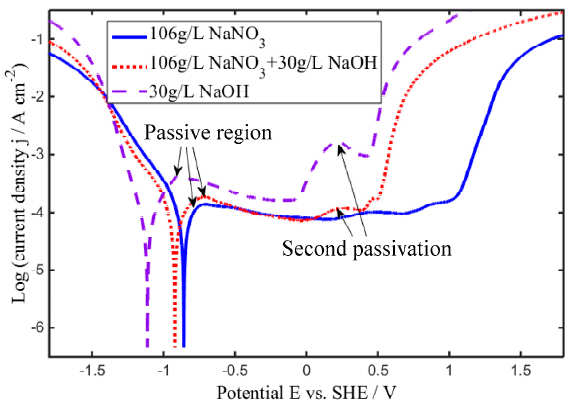
Figure 2. Potentiodynamic polarization curves of Inconel 718 in NaNO 3 , NaOH and a mixture of both.